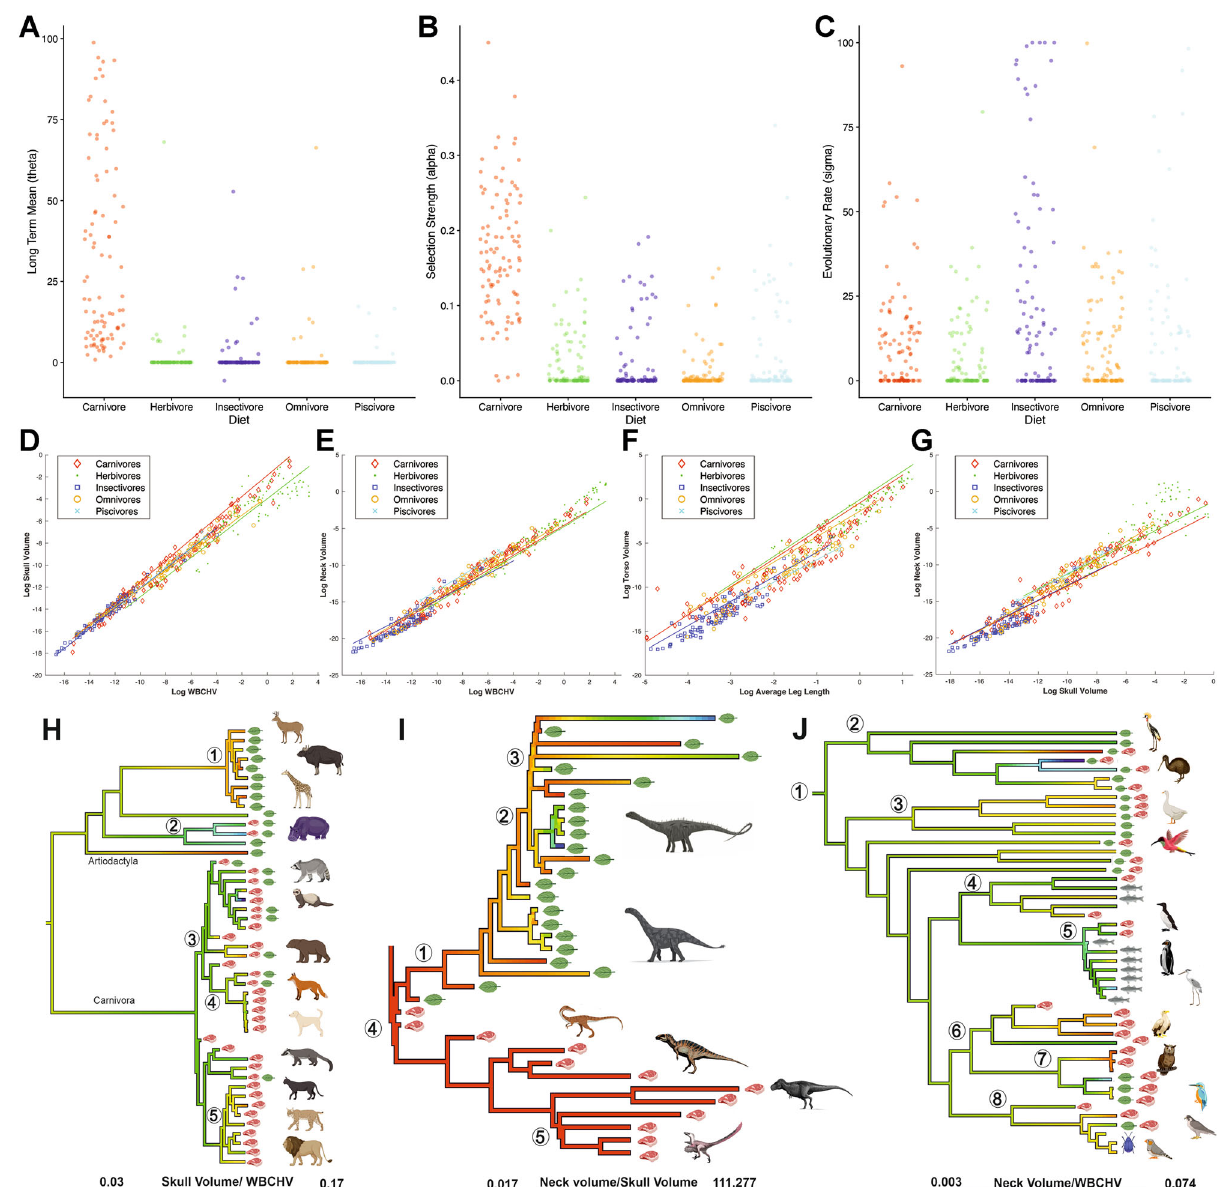
Fig. 9 | Evolution and scaling of relative head, neck and torso size in herbi- vorous tetrapods. Results for the OUwie analysis for head to neck ratio evolution with respect to dietary ecology, showing estimates of A macroevolutionary opti- mum( θ ), B selectionstrength( ɑ )and C evolutionaryrate(Hypothesis3).Inallthree panels, each point corresponds to the parameter estimate for one of the sampled simulated evolutionary regimes. Consistent with Hypothesis 8, carnivores have greater D headsizesrelativetobodysizeand A , G relativetonecksizecomparedto herbivoresandothertrophicgroups.ContratoHypothesis8, E necksizerelativeto body size appears to be similar between carnivores and herbivores. The tendency towards larger heads and smaller necks in carnivores compared to herbivores (particularly at larger body sizes) is re fl ected in evolutionary transitions between